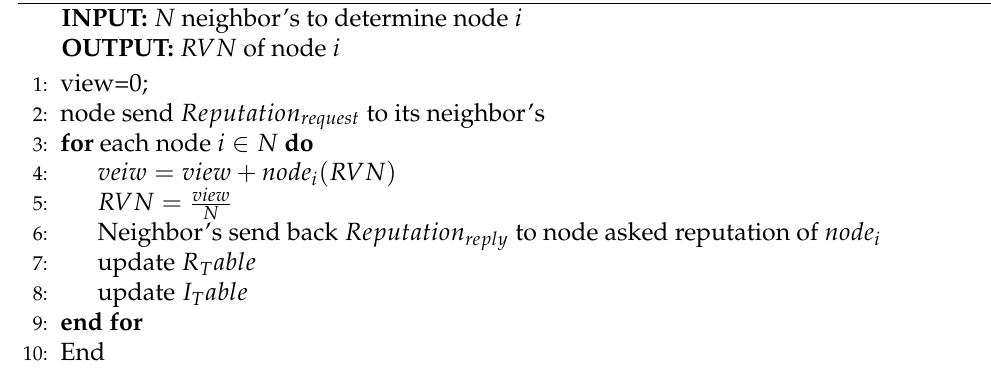
Algorithm 2 Algorithm for Neighbor’s Assessment